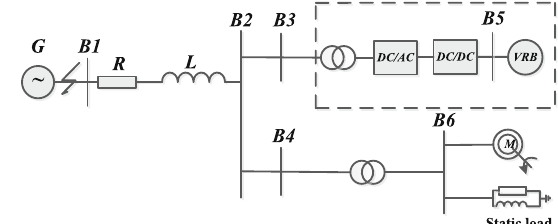
Fig. 3 Grid simulation structure diagram of